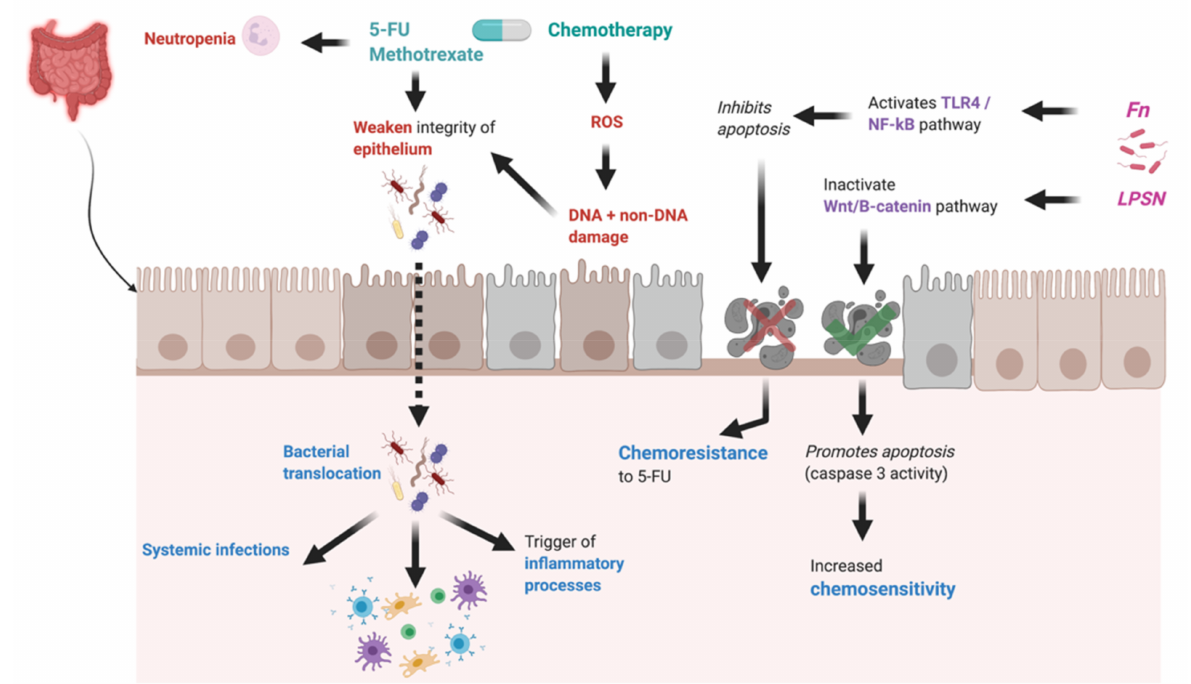
Figure 1. The effect of microbiome on chemotherapy efficacy and toxicity. The gut microbiota can affect the host response to chemotherapeutic agents by facilitating drug efficacy, promoting chemoresistance and/or mediating chemotherapeutic toxicity and side effects. On the other hand, the efficacy of anticancer therapy is dependent on microbiota-mediated innate and adaptive immune responses. As a whole, chemotherapy induces ROS-mediated DNA and non-DNA damage, resulting in bacterial translocation across the intestinal epithelium. This in turn induces an inflammatory response and can provoke systemic infections. Abbreviations: 5-FU, 5-fluorouracil; DNA, deoxyribonucleic acid; Fn , fusobacterium nucleatum ; LPSN , lactobacillus plantarum supernatant ; ROS, reactive oxygen species. The bolded arrows represent the effects of the microbiome and chemotherapy, and the broken arrow represents bacterial